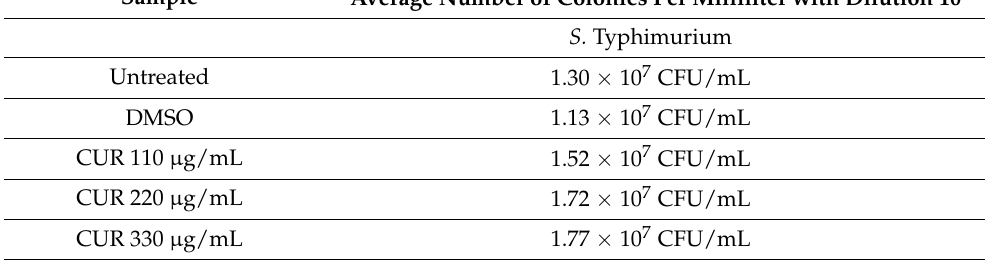
Table 1. Number of colonies on agar plates.